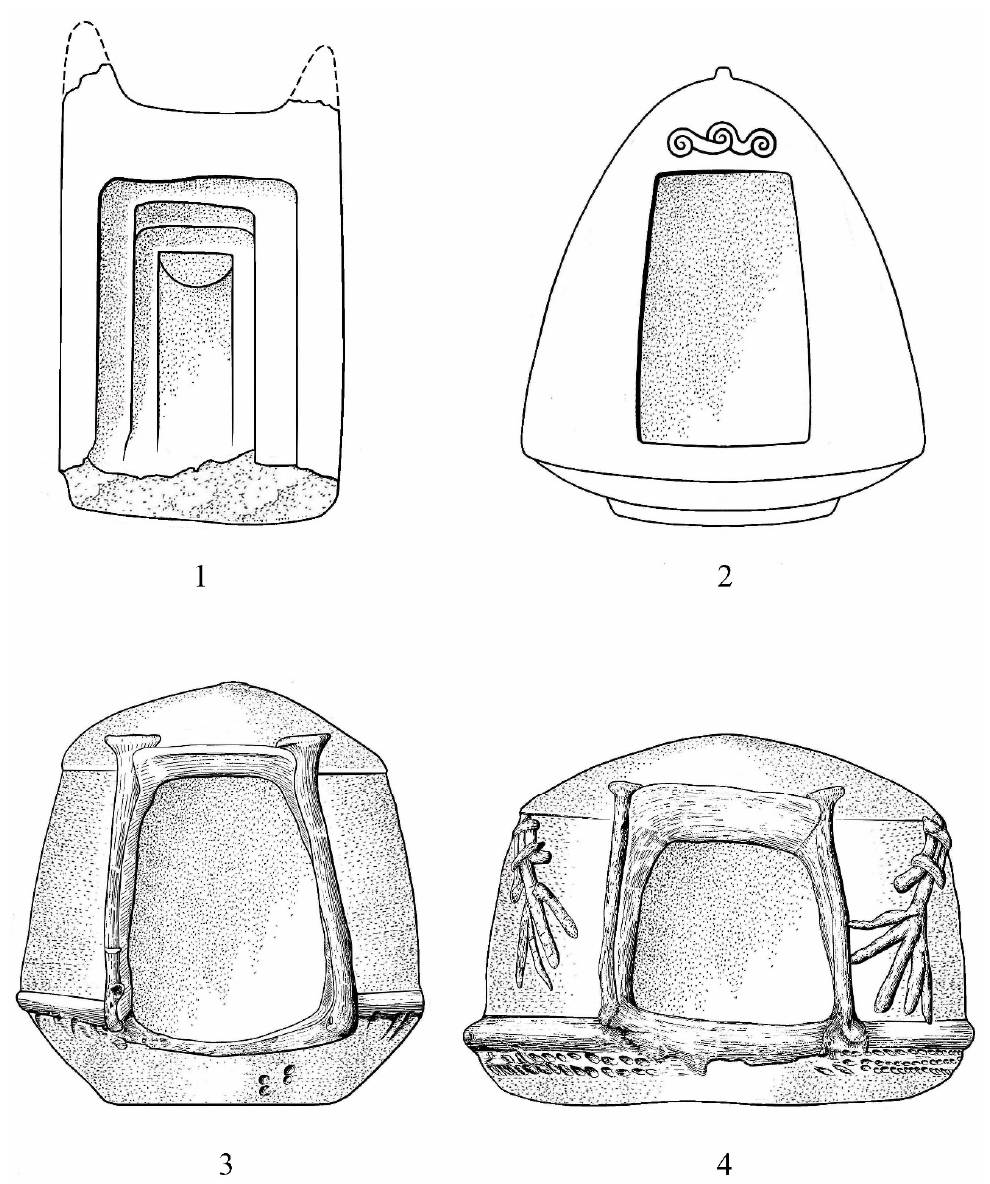
Figure 5. Portable shrines with a depiction of a curtain above the door: 1. Ur, southern Iraq, early second millennium BCE (after Woolley and Mallowan 1976, Pl. 97). 2. Ugarit (after Muller 2016, Figure 117c). 3–4. Kamid el-Loz (Metzger 1993, Pls. 73,